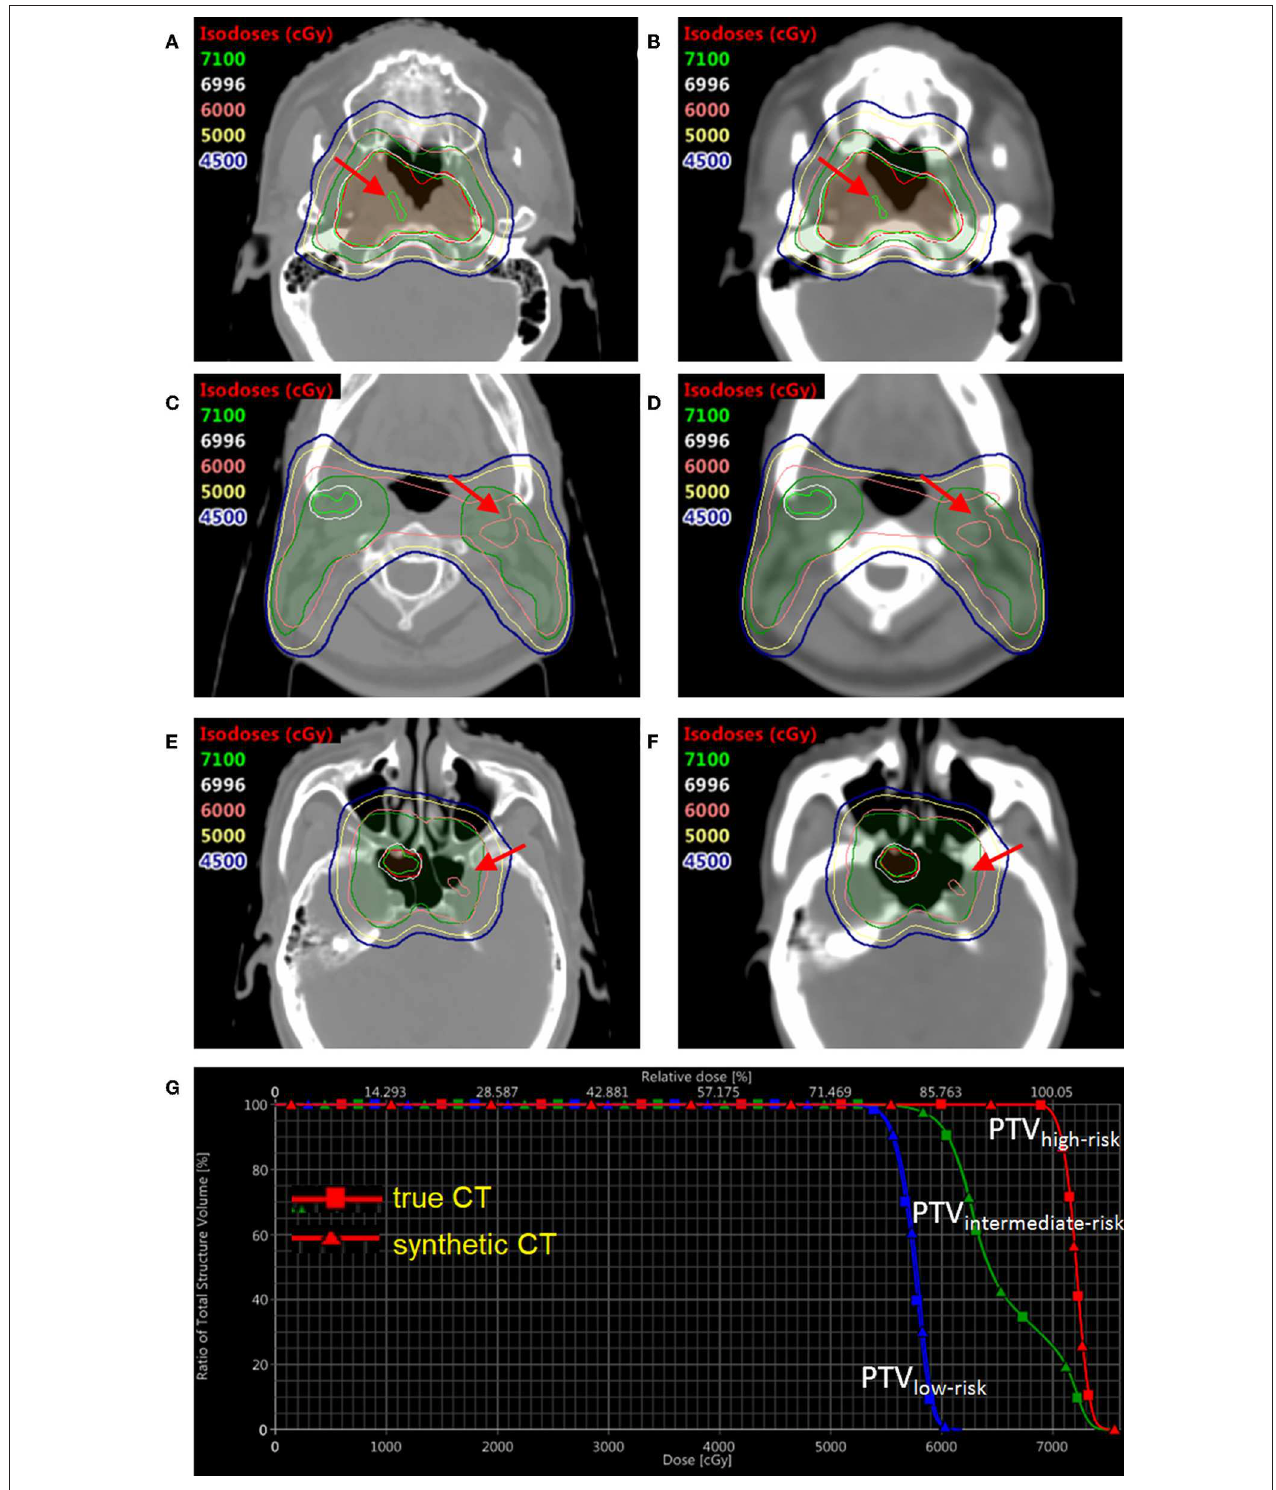
FIGURE 6 | The dose distribution and DVH comparison between true CT and synthetic CT in an example NPC patient. Three slices of true CT are shown on the left (A,C,E) ; Three corresponding slices of synthetic CT are shown on the right (B,D,F) . The DVH comparison based on true CT and synthetic CT is shown in (G) . The translucent red region is high-risk PTV with prescription dose of 69.96Gy; the translucent green region is intermediate-risk PTV with prescription dose of 60Gy; the translucent blue region (not shown in axial views here) is low-risk PTV with prescription dose of 54.4Gy. DVH with squares and triangles is based on true and synthetic CT,